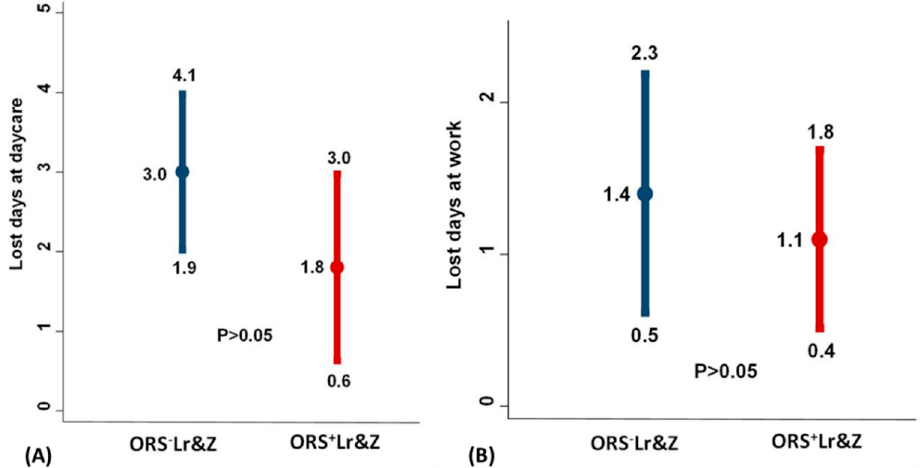
Figure 5. ( A ): Number of lost day care/nursery days for patients. ( B ): Number of lost work days for parents. Results are presented with means and 95% confidence intervals. Comparisons between the ORS + Lr&Z and the ORS - Lr&Z arms were performed by the Mann-Whitney U test ( p > 0.5). The number of vomiting episodes was comparable between the ORS − Lr&Z and the ORS + Lr&Z groups at baseline: mean ± SD, median (IQR) 0.09 ± 0.28, 0 (0, 0) vs. 0.07 ± 0.26, 0 (0, 0) respectively, p = 0.4, while no vomiting episodes were recorded during the study period in any of the two groups. The consumed volume of ORS during the first 24 h did not differ between the ORS + Lr&Z and the ORS − Lr&Z groups: mean ± SD, median (IQR) 309.8 ± 235.3, 265 (120, 415) vs. 326.5 ±